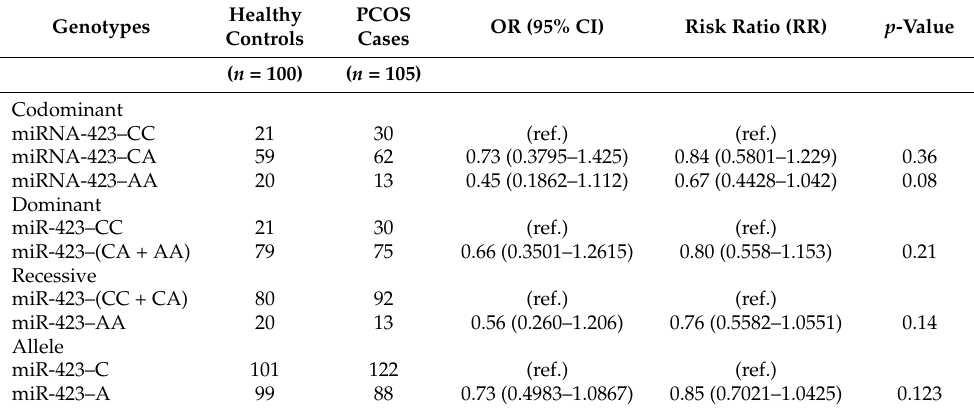
Table 8. Association of miR-423 rs6505162 C > A gene variation in PCOS cases and controls.